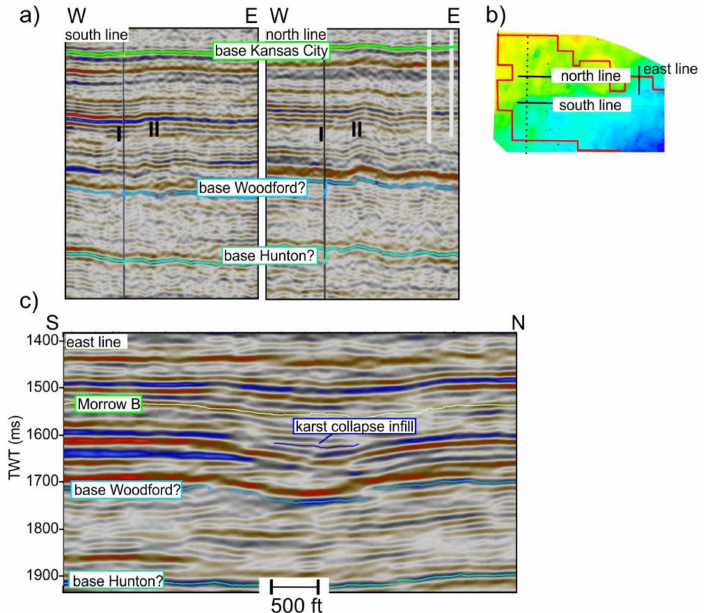
Figure 7. ( a ) Two seismic lines through the feature (labeled I and II in Figure 6) in the western part of Farnsworth Field; locations of lines indicated in ( b ); ( b ) portion of Farnsworth Field (outlined in red) and locations of seismic lines; ( c ) karst collapse infill structure in the eastern part of Farnsworth Field; location of east line indicated in ( b ). Vertical lines in ( a ) mark the dashed line in ( b